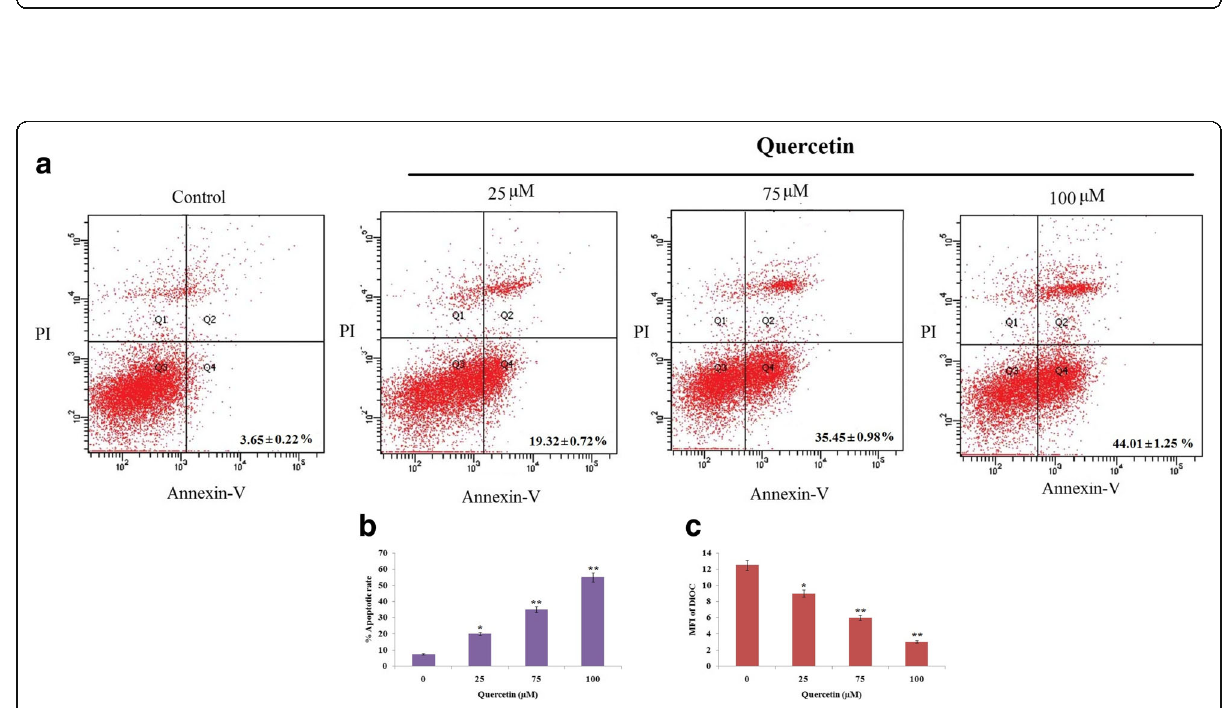
Fig. 3 Quercetin causes apoptosis of RB Y79 cells in vitro. a The control cells (untreated), the treated cells received various concentration of Quercetin (0-100 μ M) for 24 h. Extent of apoptotic cells were assessed by flow cytometry subjecting cells to staining of propidium iodide (PI) and Annexin V-fluorescein isothiocyanate (FITC). b Results represent analysis of the total apoptotic cell population. All the data presented are the means ± SD ( n = 3). * P < 0.05, ** P < 0.01 against control. c Quercetin caused ΔΨ m collapse in cancerous RB Y79 cells. Flow cytometric analysis was done in order to record the mean fluorescence intensity (MFI) of DiOC 6 . All the values are the means ± SD ( n = 3). * P < 0.05, ** P < 0.01 against